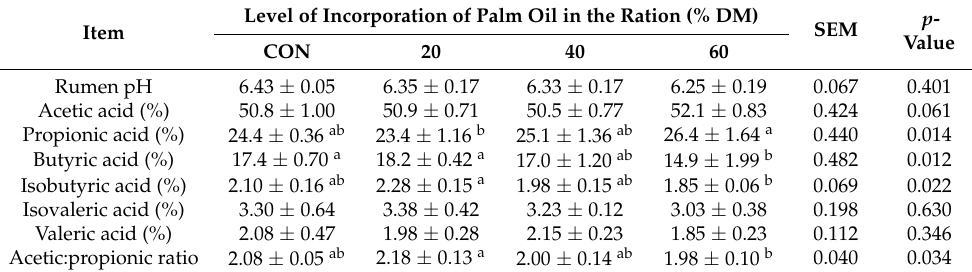
Table 6. Effect of palm oil supplementation on rumen fermentation parameter in